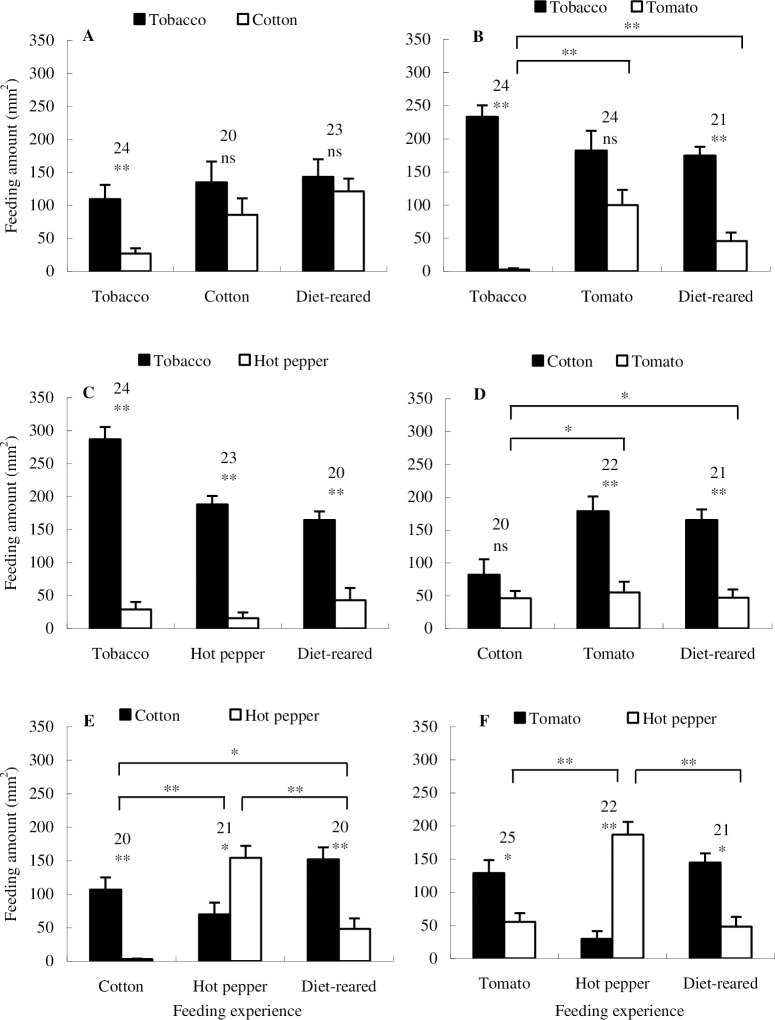
Mean leaf consumptions of H. armigera larvae with different feeding experience under dual-choice conditions.“*” and “**” attached to the bar pairs indicate significant within-group difference at P = 0.05 and P = 0.01 levels, and “ns” indicates no significant within-group difference, analyzed by paired t test. The numbers attached to bar pairs indicate replications. “*” and “**” attached to the lines spanned over two bar pairs indicate significant between-group difference at P = 0.05 and P = 0.01 levels, respectively, analyzed by independent two-sample t test (to simplify the figure, between-group differences with no significance are not shown).